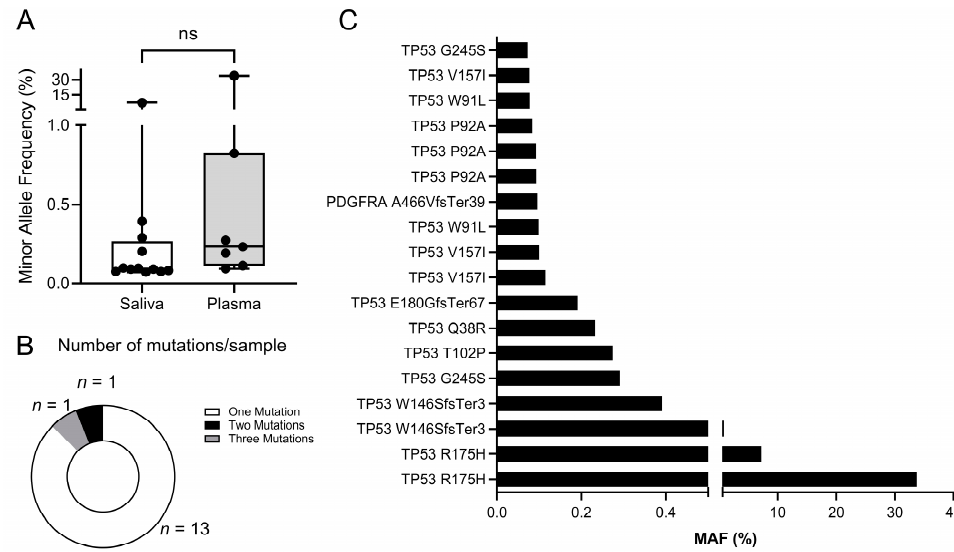
Figure 3. Mutations found in saliva and plasma. ( A ) A total number of 18 mutations (SNVs, MNVs and INDELs) were found in 15 samples, with similar minor allele frequencies (MAF %) between saliva and plasma. ( B ) Number of mutations per sample. Samples normally had single mutations ( n = 13), although multiple concurrent mutations were also found. ( C ) Minor allele frequencies (MAF %) of mutations found. TP53 was the most frequently mutated gene (95% of samples).